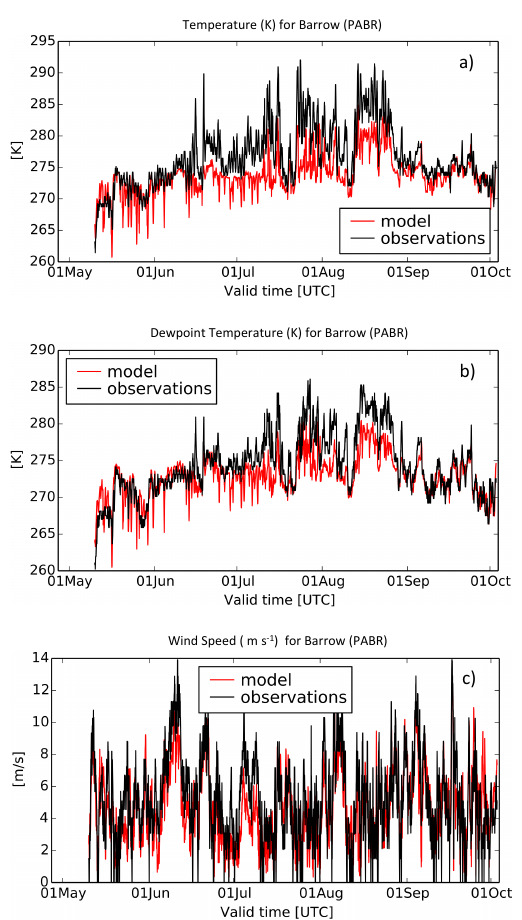
Figure 12. As in Fig. 8, but for Barrow, AK (station ID: